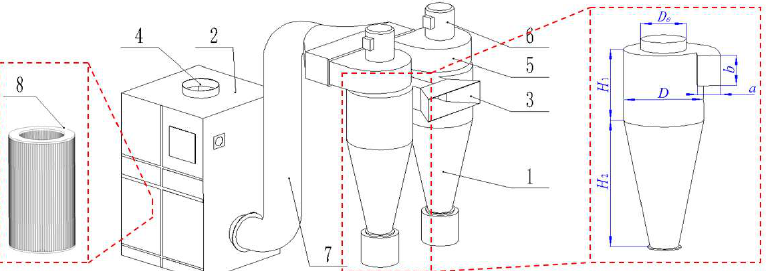
Figure 2. Total amount dust collection device: 1. Cyclone separator. 2. Filter cartridge dust collector. 3. Air flow inlet. 4. Air flow outlet. 5. Cyclone separator fan. 6. Variable frequency motor of cyclone separator. 7. Pipeline. 8. Filter element.